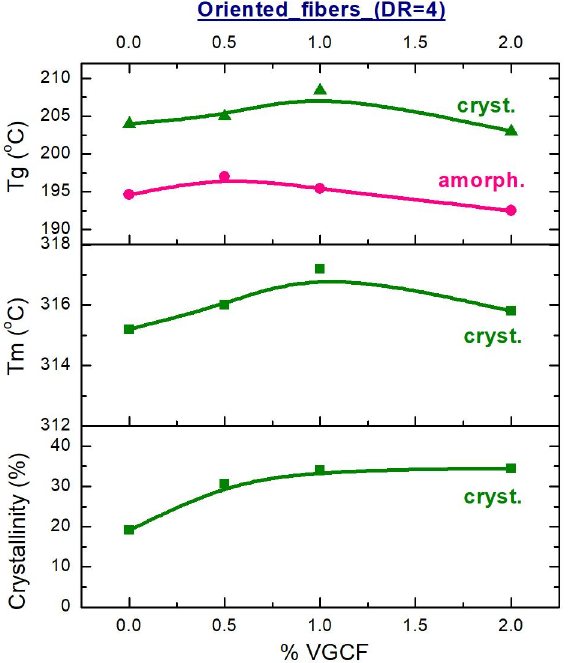
Figure 13. Dependences of the glass transition and melting temperatures, as well as the degree of crystallinity of the oriented composite fibers before (amorph.) and after crystallization (cryst.) on the content of the nanofiller.